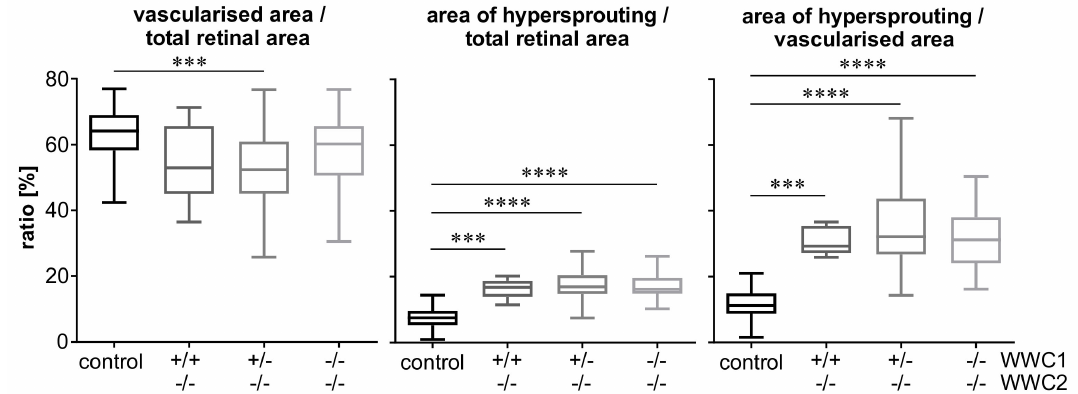
Figure 3. Results of evaluation of vascularised and hypersprouting areas as indicated in P6 retinal whole-mounts. In this and the following diagrams, data are presented of n = 42 control eyes, n = 8 WWC1 +/+ WWC2 − / − eyes, n = 56 WWC1 +/ − WWC2 − / − eyes, and n = 23 WWC1 − / − WWC2 − / − eyes. Statistical significance of differences between the groups is denoted by asterisks: *** p < 0.001, **** p < 0.0001.